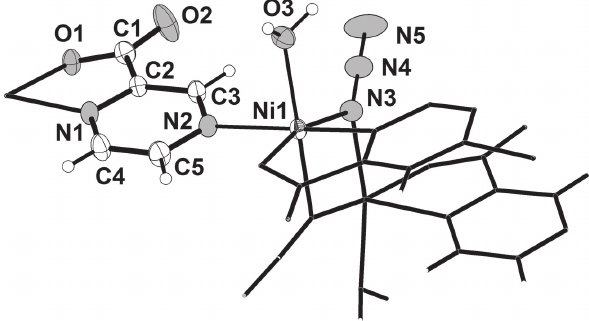
Table 1: Data collection and handling.